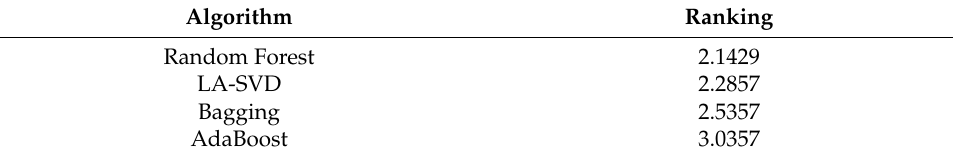
Table 10. Ranking obtained by the Friedman test.